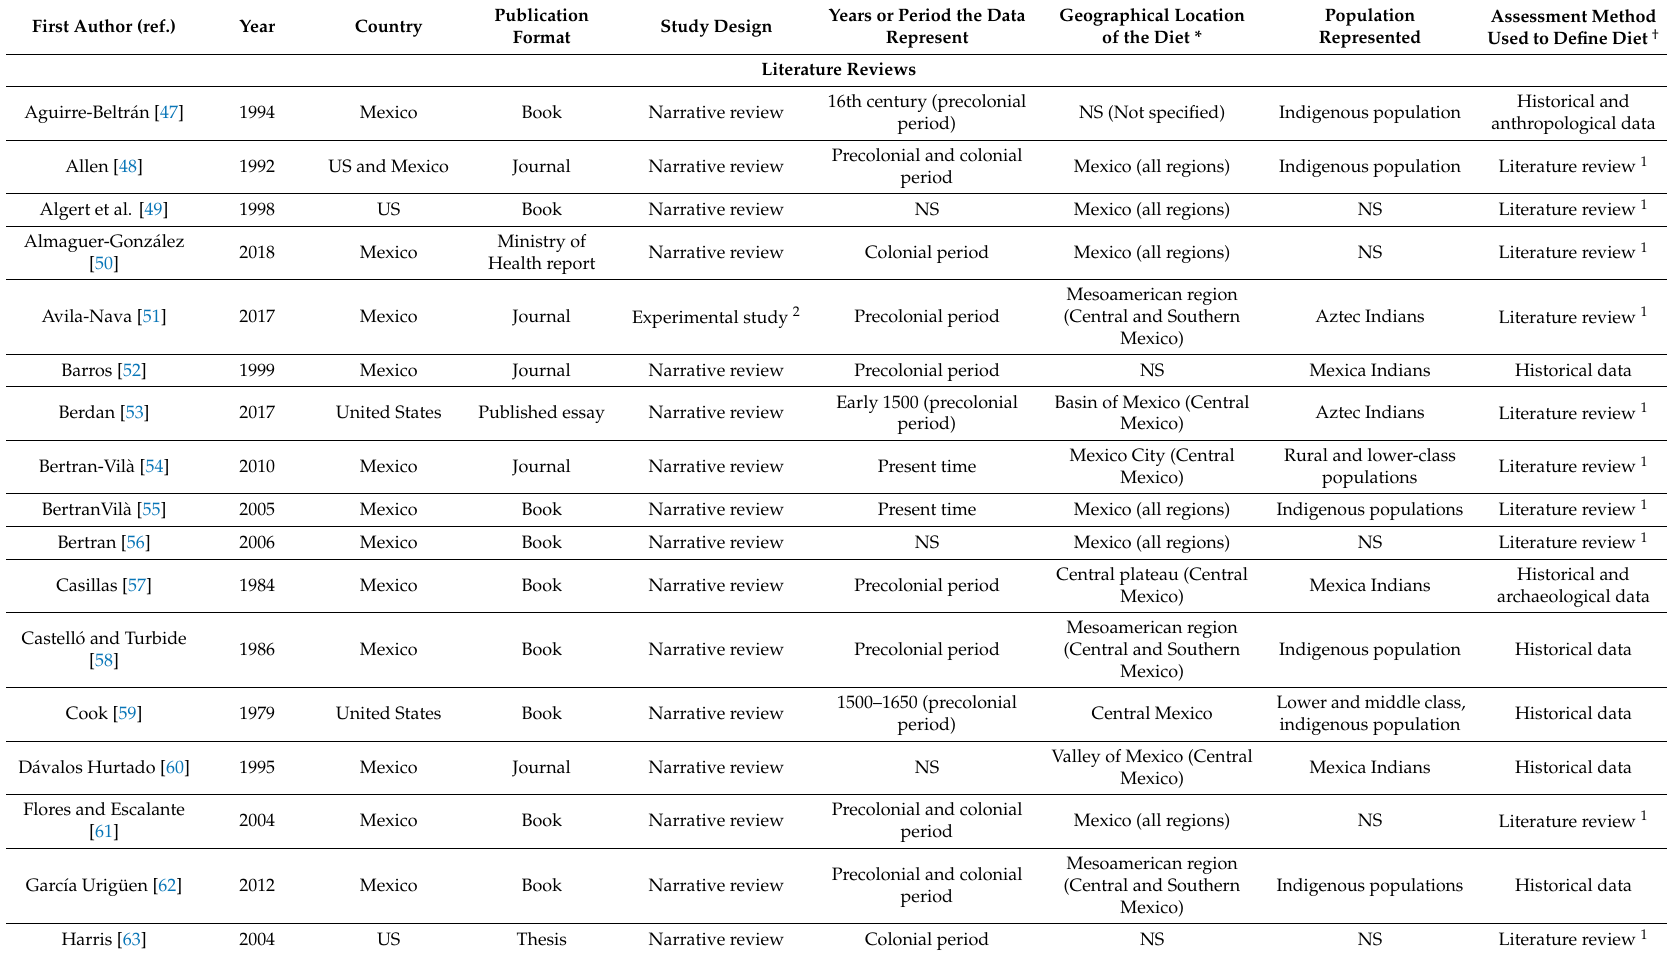
Table 1. Characteristics of included